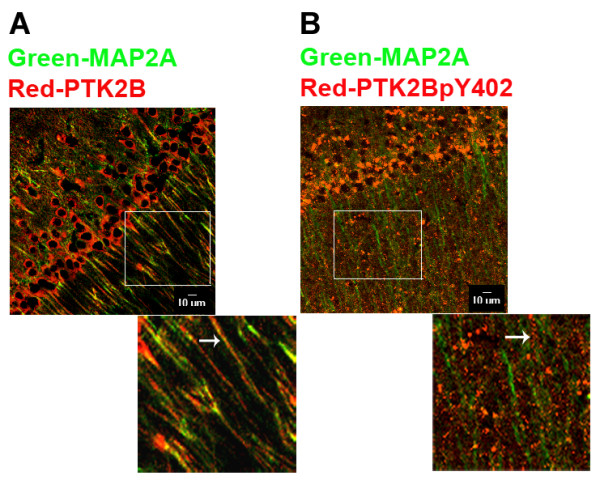
Localization of PTK2B and PTK2BpY402 in dendrites of CA1 hippocampus neurons in Tg mice. Labelling with antibodies to PTK2B, PTK2BpY402, and MAP2A were performed exactly as in Figure 3. The labelled sections were imaged using confocal microscopy and are shown as super-imposed images of PTK2B and MAP2A (A) or PTK2BpY402 and MAP2A (B). Sections were obtained from 20 mo-old mice. Enlarged images of dendrite regions from the stratum radiatum enclosed by white squares in A and B are presented below the respective images. Note the relatively uniform distribution of PTK2B in dendrites of the CA1 region as compared to the large puncta of immunolabelling by anti-PTK2BpY402. Arrows point to the two types of labelling by anti-PTK2B and anti-PTK2BpY402 antibodies along the path of a dendrite in CA1 stratum radiatum. Bar: 10 μm.